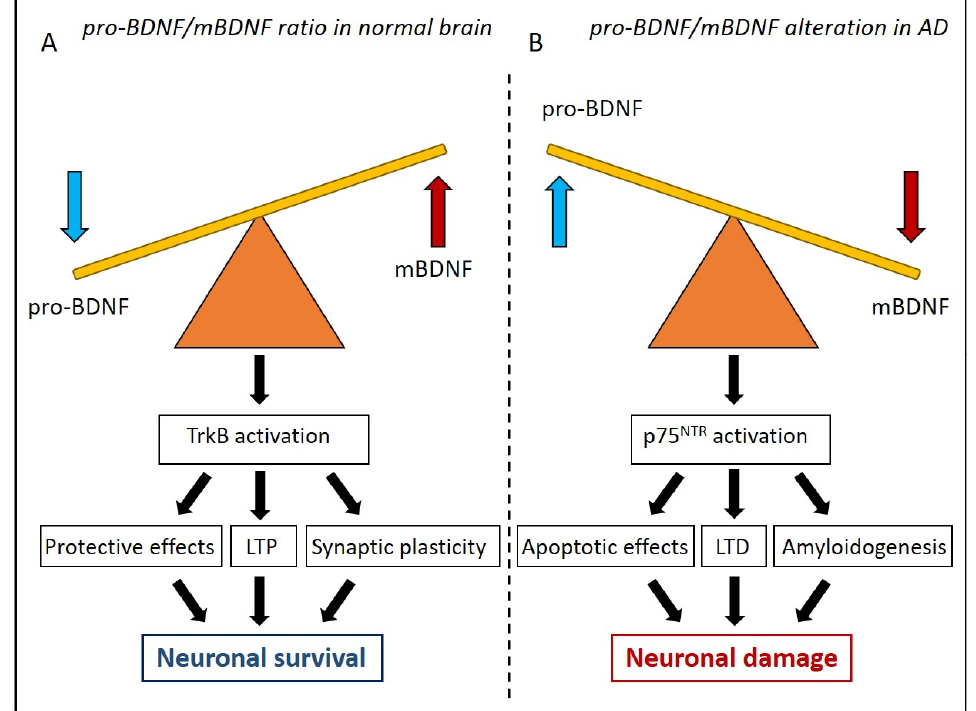
Figure 1. Schematic illustration of pro-BDNF/mBDNF ratio in normal brain and in Alzheimer’s dis- ease (AD). ( A ) In a physiological condition, BDNF-TrkB signalling exerts protective effects, improving hippocampal long-term potentiation (LTP) and synaptic plasticity and promoting neuronal survival. ( B ) In AD, the alteration of pro-BDNF/mBDNF ratio and the accumulation of pro-BDNF leads to the activation of p75 NTR signalling pathway involved in programmed cell death, activation of long-term depression (LTD), and the biogenesis of Ab amyloid protein (amyloidogenesis), promoting neuronal damage.